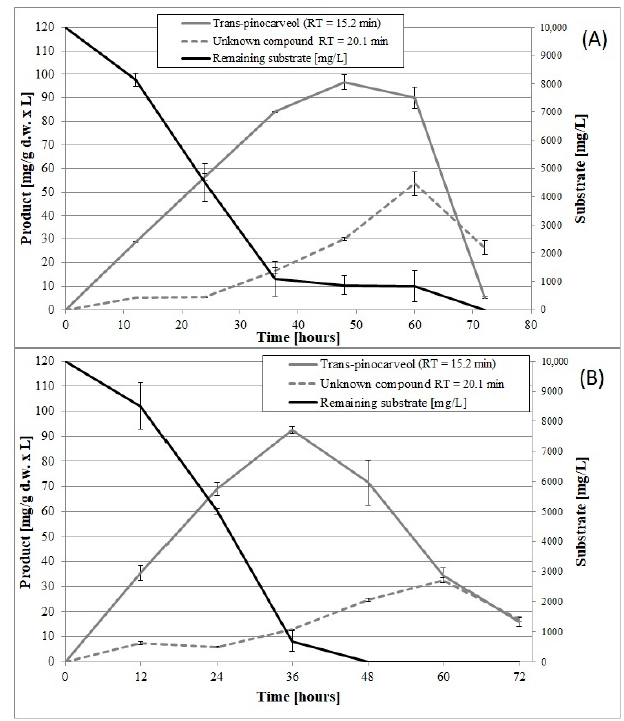
Figure 5. Time course of β -pinene biotransformation on basal medium (BM) by the wild-type strain ( A ) and mutant 1–6 ( B ) of the fungus C. pannorum A-1. An identical biomass concentration (1.5 g dry mass per L) was used in each sample. Bars represent the standard deviation of two independent samples.